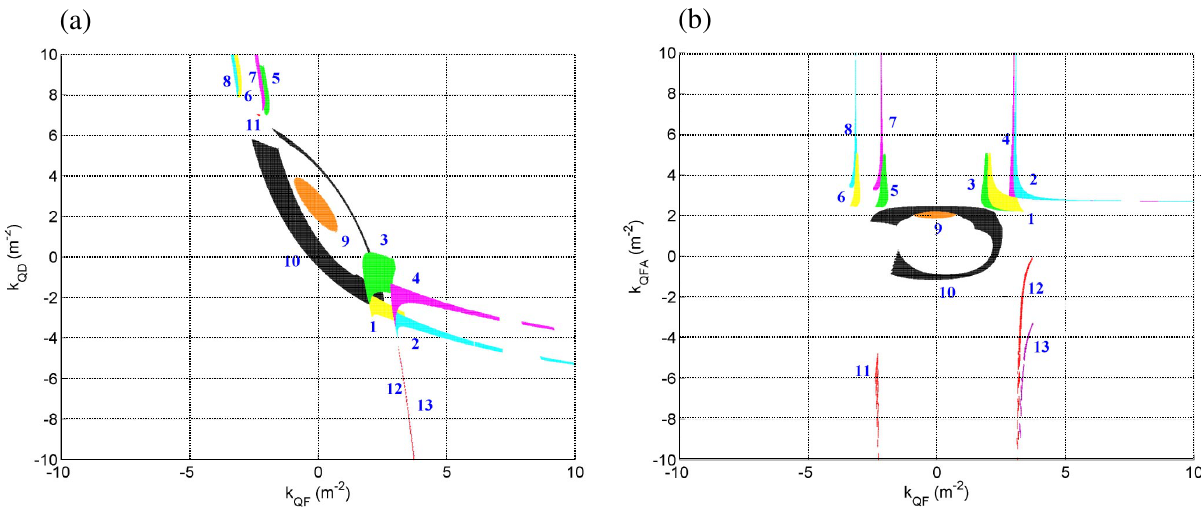
FIG. 7. (Color) k -space data shown in Fig. 7 is shown from two different perspectives—projecting on the kQF and kQD axis (left) and projecting on the kQF and kQFA axis